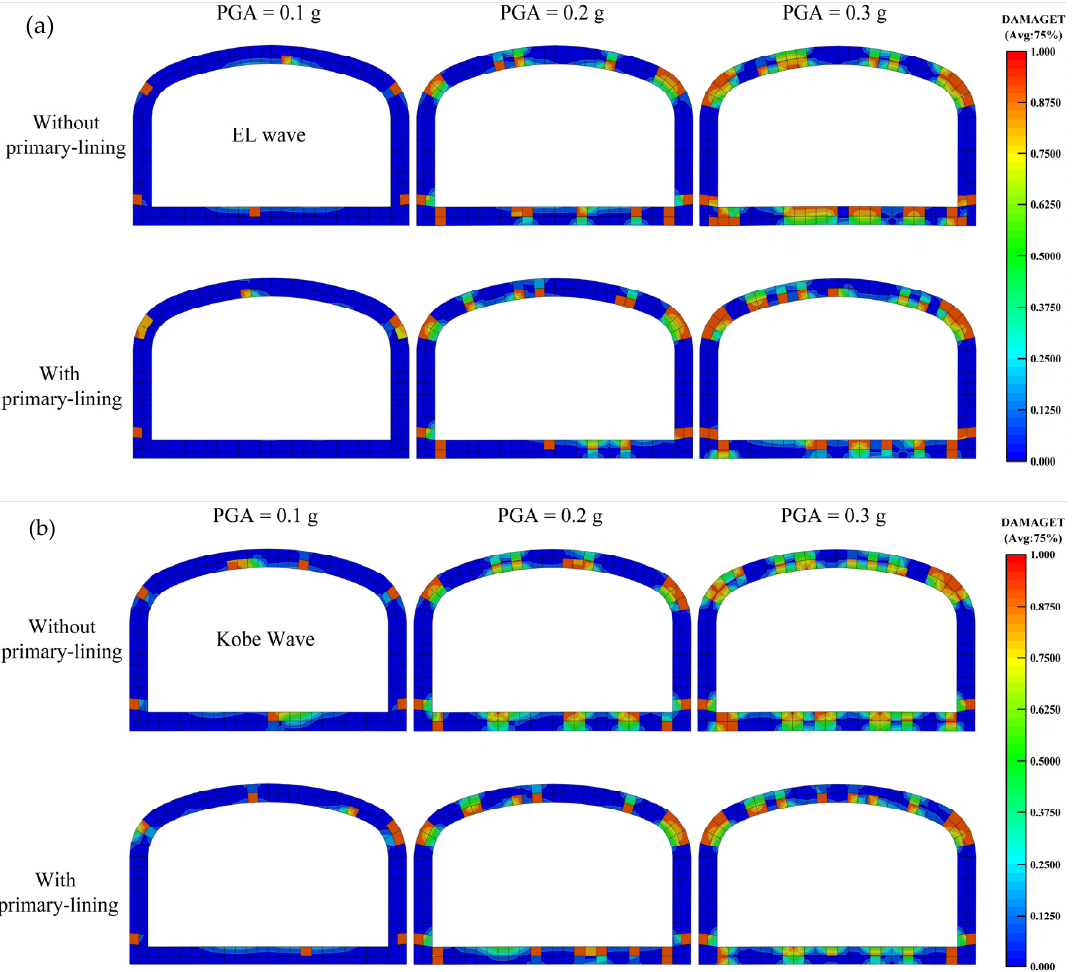
Figure 23. Seismic tensile damage of tunnel with PGA = 0.1 g, 0.2 g, 0.3 g ( a ) EL-Centro Wave ( b ) Kobe wave.